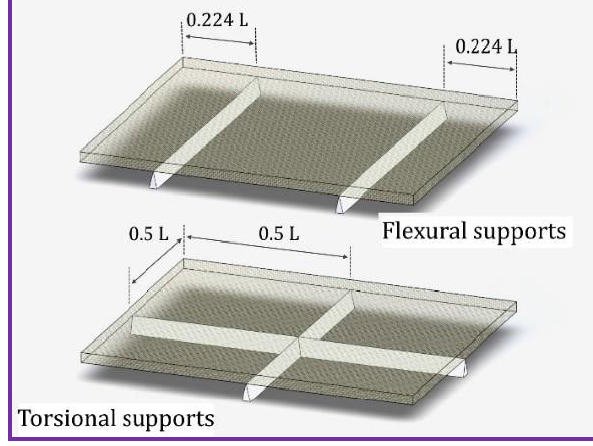
Figure 8. Support position for locating a sample. Table 3. Resonance frequency and elastic constants of